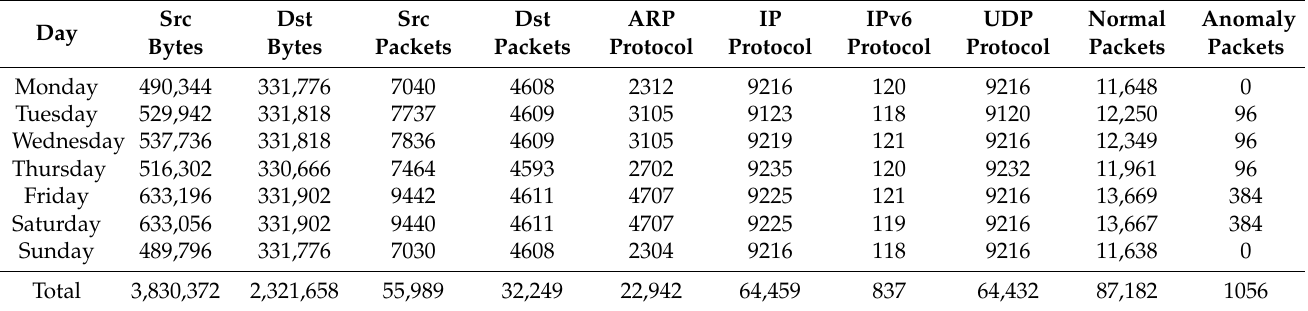
Table 3. Dataset